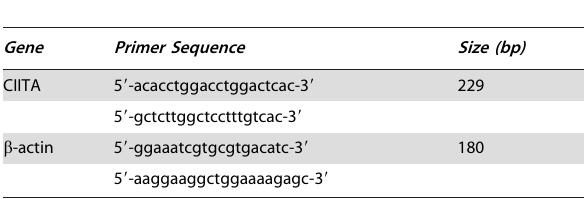
Table 1. Primers used for real-time PCR.